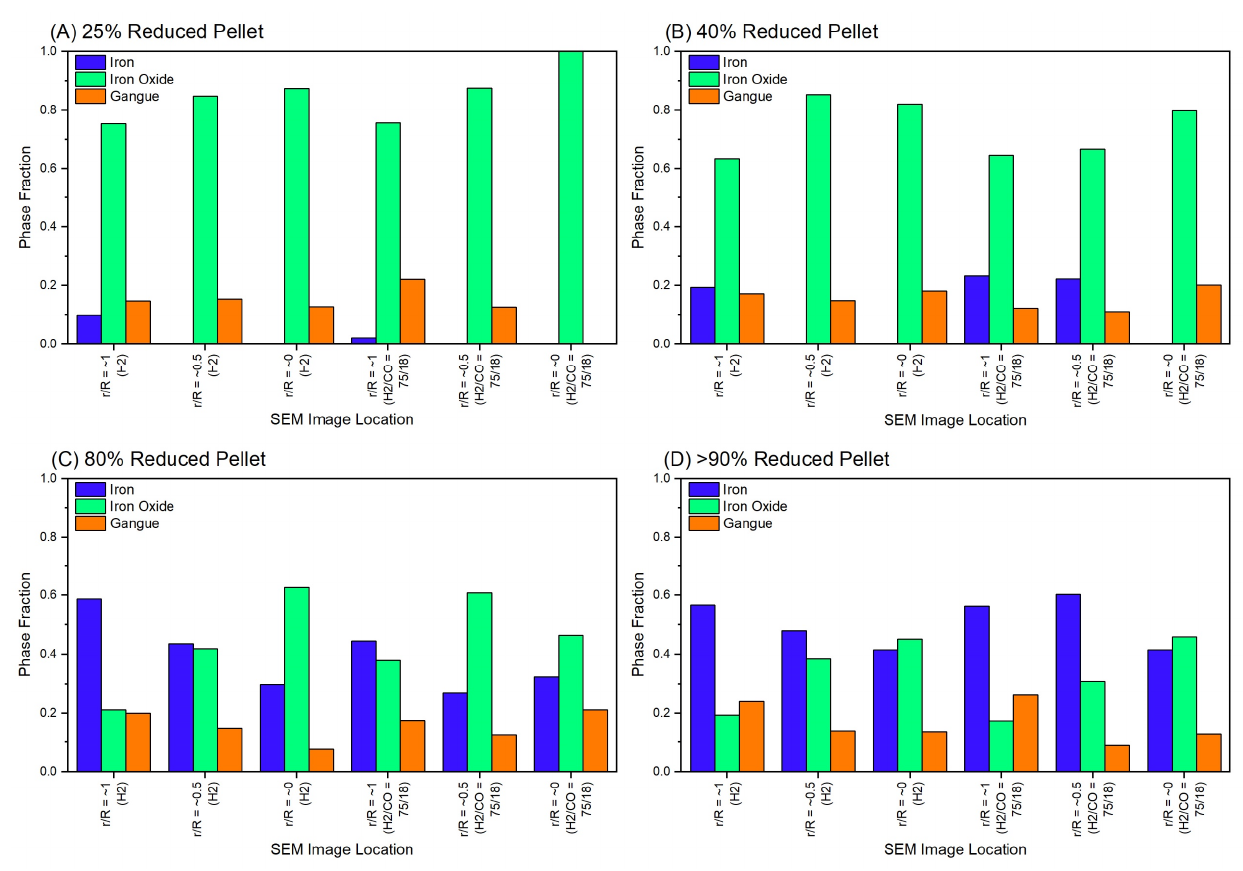
than the degree of reduction in the core region of the pellet. In some cases, a spike in the value of porosity was observed due to cracks in the pellet (example: Figure 7A: X = 0.25, image 7 & Figure 7B X = 0.95, image 7). Figure 6. Phase composition comparison of SEM images of ( A ) 25% reduced, ( B ) 40% reduced, ( C ) 80% reduced and ( D ) >90% reduced pellet obtained using H 2 and H 2 /CO = 75/18 gas mixture.